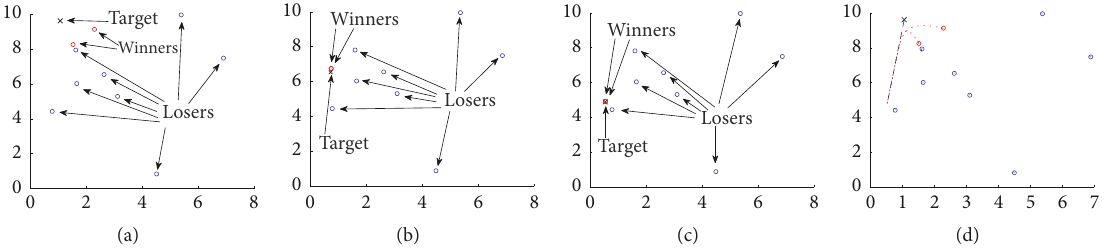
Figure 4: ( Phase 1 ) With 𝑘 = 2 , snapshots for centralized model (12) with all-to-all communications for moving target tracking and the corresponding tracking trajectories, where initial locations of mobile robots and the moving target are randomly generated. In this sense, ten mobile robots compete with each other for tracking the moving target, and only two of them with the minimum distance from the moving target (the winners) are activated to track while the rest ones (the losers) keep unmoved. (a) Snapshots at 𝑡 = 0 s. (b) Snapshots at 𝑡 = 1 s. (c) Snapshots at 𝑡 = 3 s. (d) Actual path of the moving target and tracking trajectories of different mobile robots.